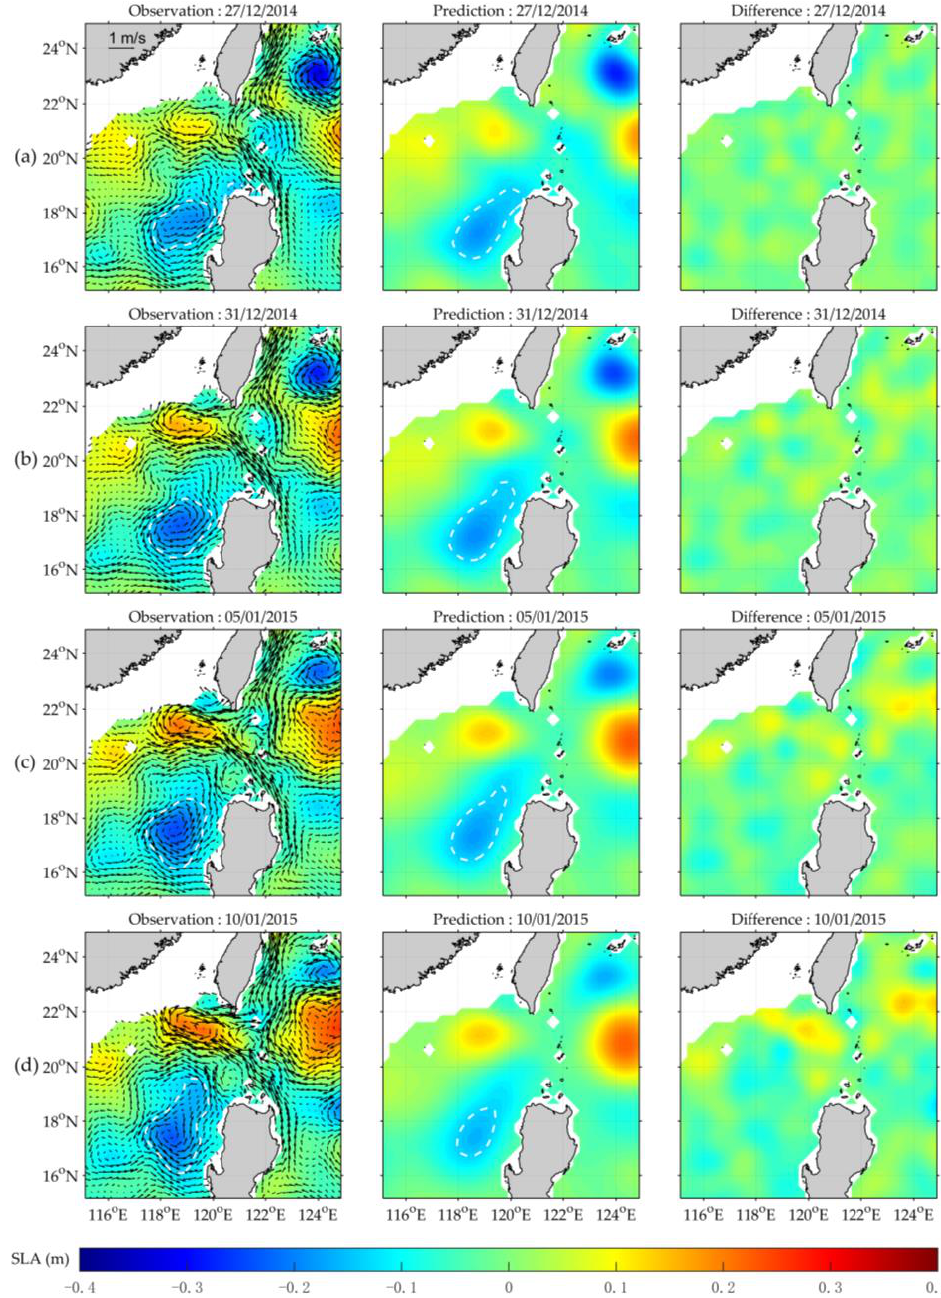
Figure 11. Comparison between observed and predicted SLA at ( a ) day 1, ( b ) day 5, ( c ) day 10, ( d ) day 15. The white dashed line represents the − 0.13 m contour, and the blue area around the white dashed line is the cyclone eddy. The left column shows the results from observation, the middle column shows the results from the prediction, and the right column shows the difference between the observed and predicted SLA . Black vectors are the variation of geostrophic current.